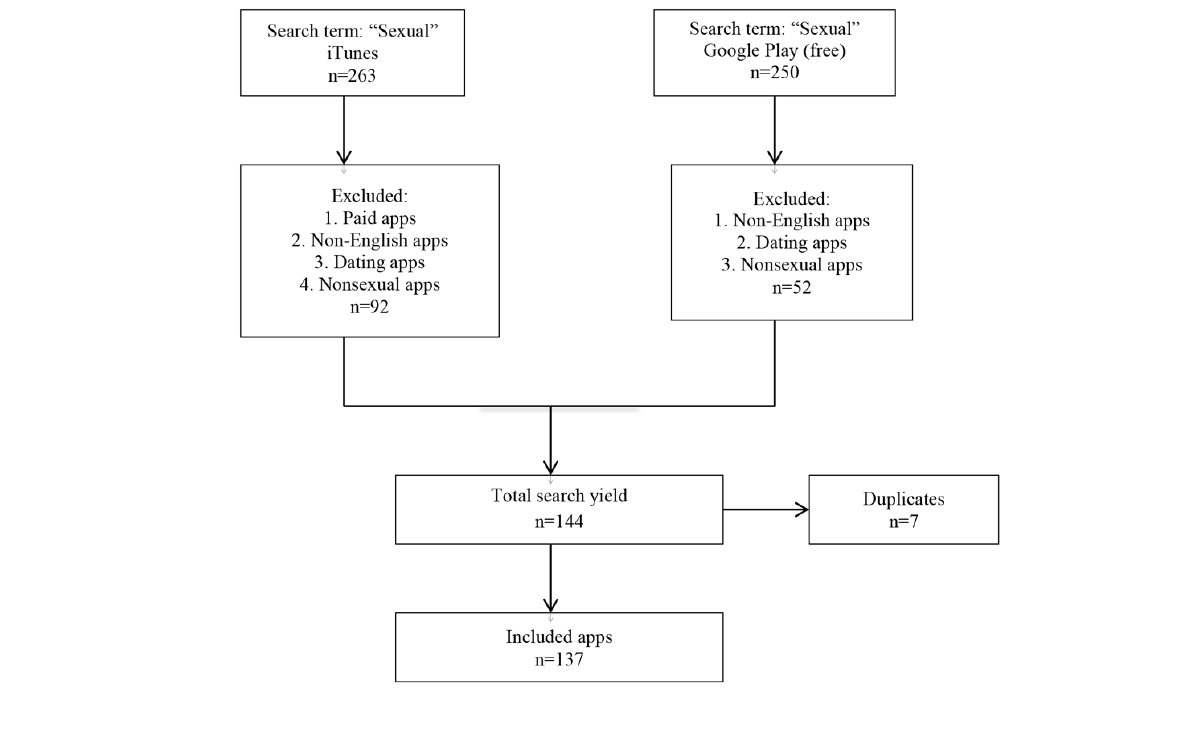
Table 2. Results of dating app review (N=60).